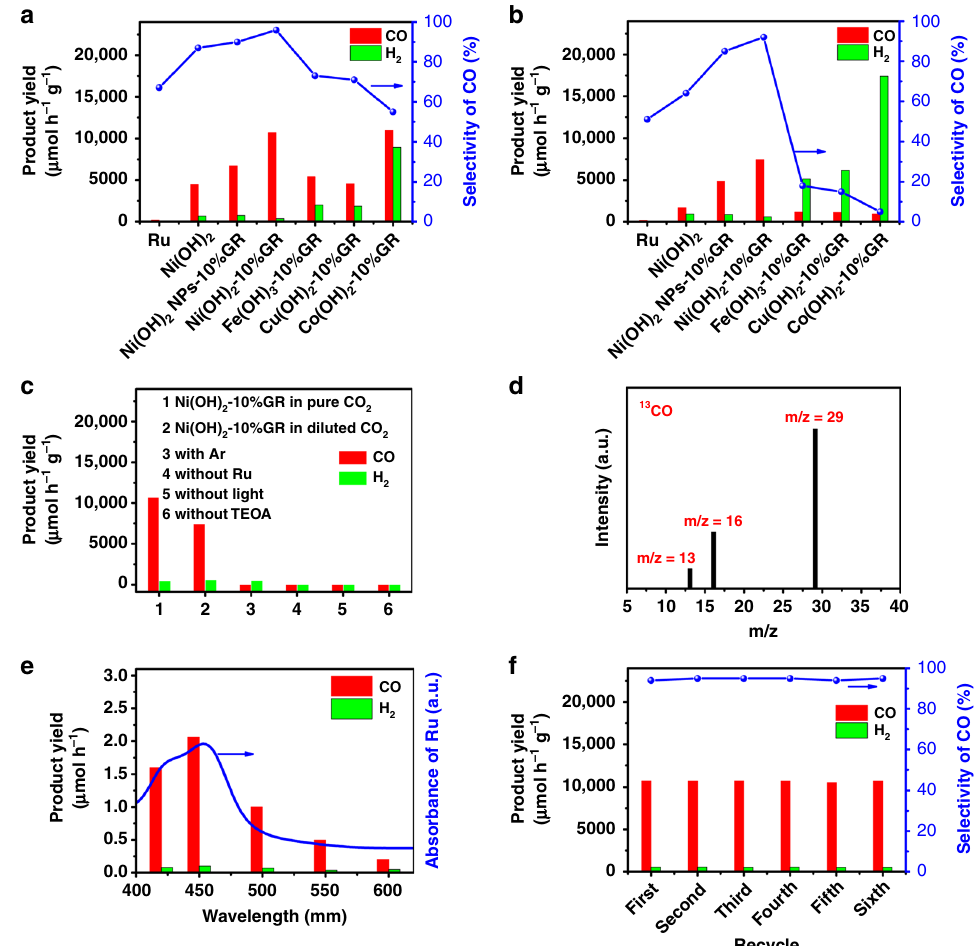
Fig. 3 The photocatalytic performance of CO 2 reduction. CO 2 photoreduction performance over Ru, Ni(OH) 2 , Ni(OH) 2 NPs-10%GR, Ni(OH) 2 -10%GR, Fe